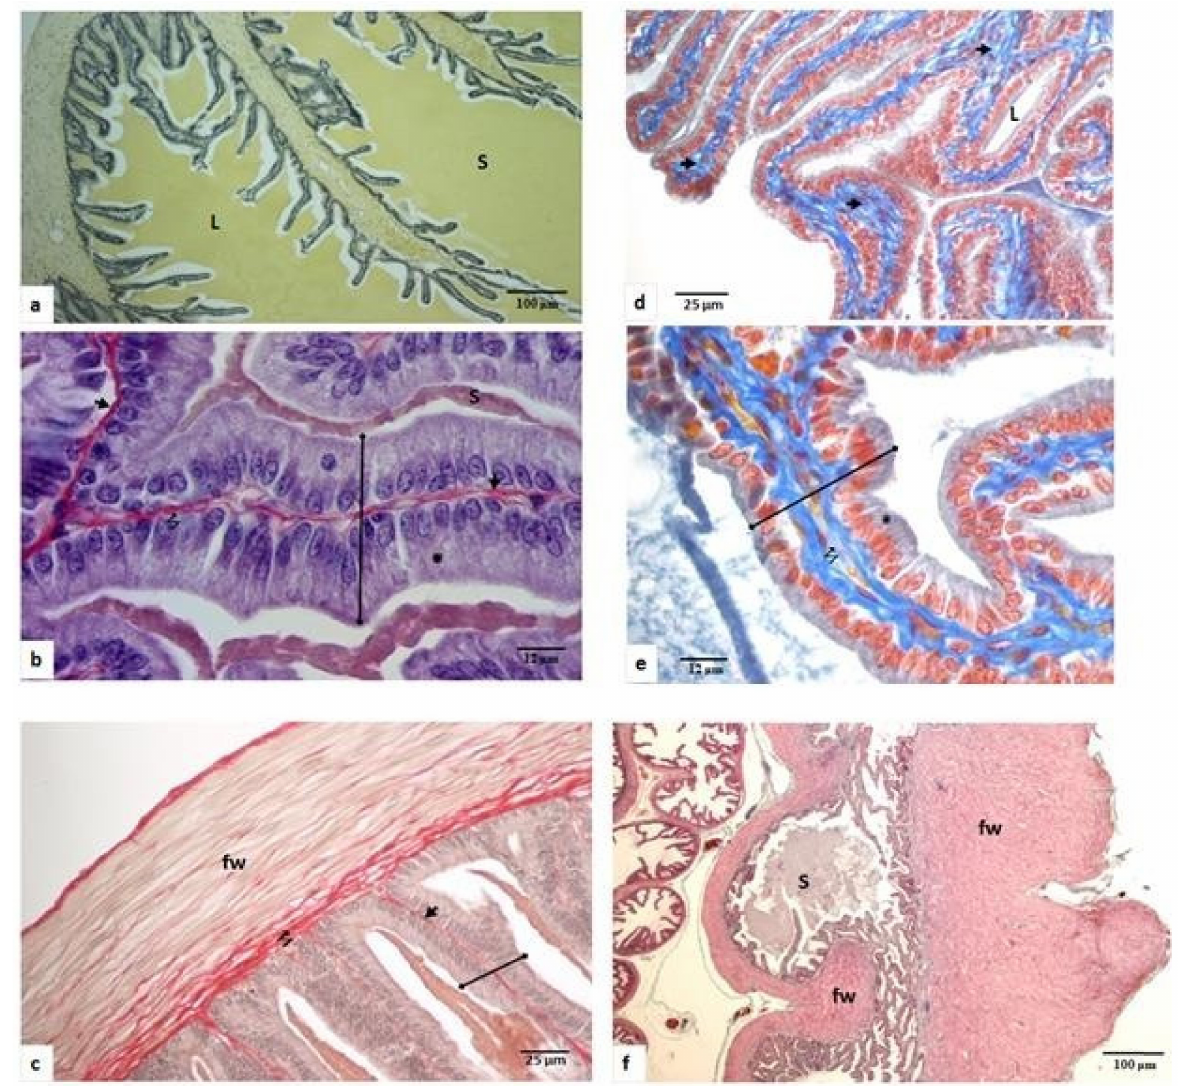
Figure 3. Histological seasonal changes of the seminal vesicle of the Libyan jird ( Meriones libycus ). ( a–c ) In the breeding period (spring and onset of summer). ( d–f ) In the nonbreeding phase (end of summer, fall, winter). Secretion (S), epithelial folds ( ), epithelial fold axis ( ), supranuclear zona of epithelial cells (*), lumen (L), connective fibers ( ), fibromuscular wall (fw). Staining: ( a ) Van-Gieson; ( d , e ) Azan of Heidenhain; ( b , c , f ) Sirius red. ( a , f ) ×100; ( b , e ) ×1250; ( c , d ) ×400.